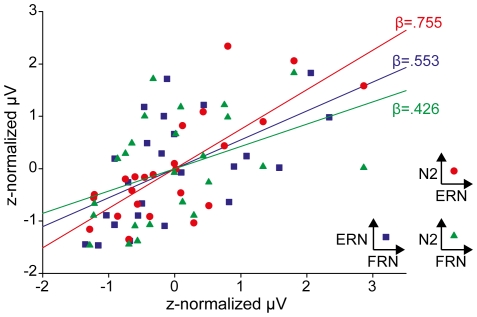
Regression analyses between FRN, N2, and ERN.Peak amplitudes of the ERPs were z-normalized. Bivariate regression analyses between the N2 and ERN revealed a strong relationship (β = .755; SEM = .140; t = 5.407; p<.001) between the N2 and ERN, and much less shared variance between the N2 and FRN (β = .426; SEM = .193; t = 2.21; p = .038). Coefficents of the bivariate regression between ERN and FRN are in between the aforementioned ones (β = .553; SEM = .178; t = 3.11; p = .005).